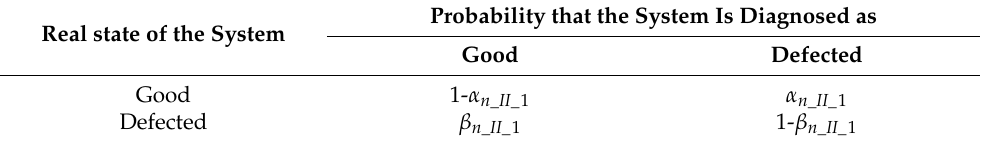
Table 1. The probability of 1st stage inspection results dependent on a real state of the system. Probability that the System Is Diagnosed as Real state of the System